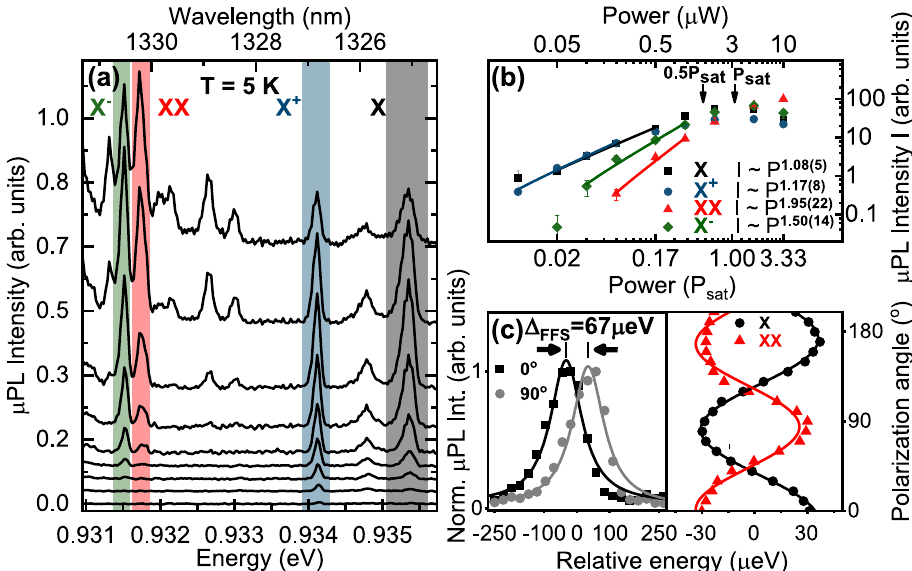
Figure 1. μPL spectra from the investigated InGaAs/GaAs QD embedded in a mesa of 1.3 μm diameter at 5 K. X —exciton, X + —positive trion, X − —negative trion, XX —biexciton. ( a ) Spectra for different excitation powers in the range of (0.05–10) µ W . ( b ) Double logarithmic plot of the µPL intensity as a function of excitation power. Symbols denote the measured data points, the solid lines represent I ∝ P α dependence with a near quadratic (1.95) and linear (1.08) behavior for biexciton and exciton, respectively. Positive and negative trions exhibit superlinear dependence (1.17 and 1.50, respectively). ( c ) Polarization-resolved µPL spectra for perpendicular polarization angles for X in the left panel and polarization dependence of emission energy for X and XX in the right panel, both indicating exciton fine structure splitting of (cid:31) FSS = 67 µ eV